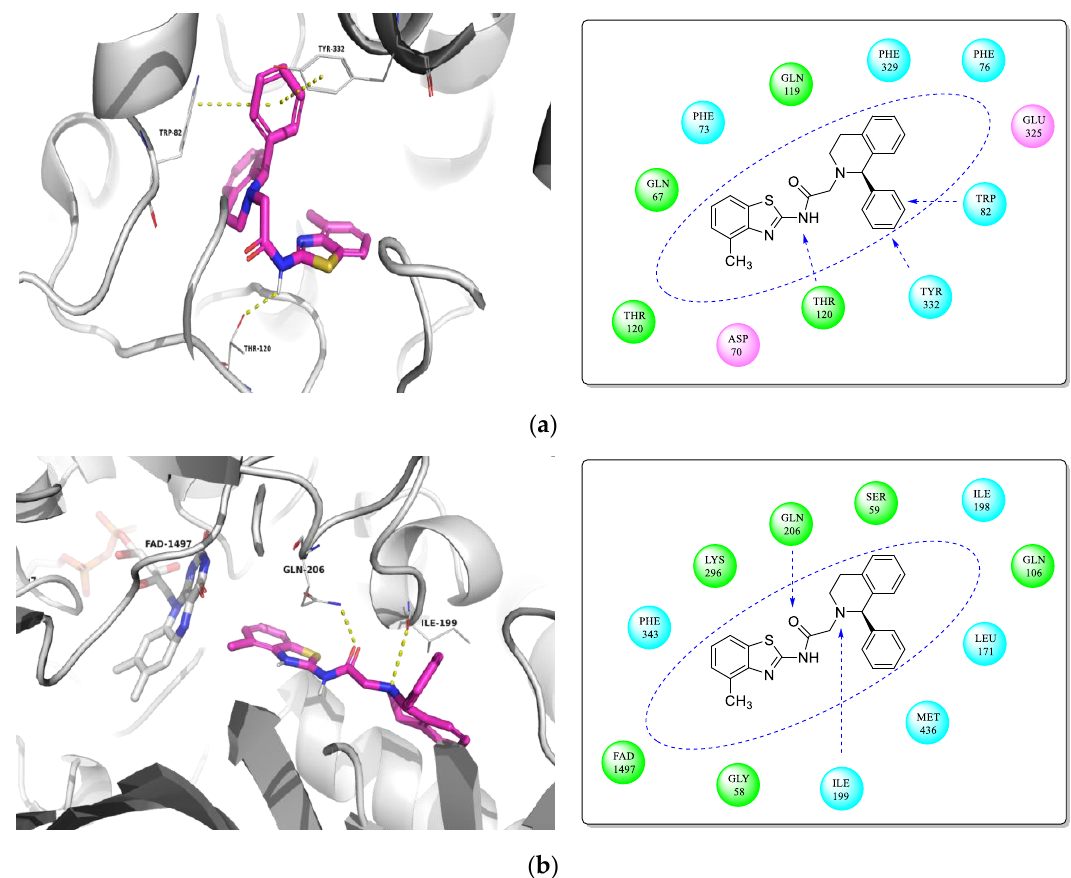
Figure 3. ( a ): Docking model of compound 4g with BuChE. Atomic colors: red carbon atoms of 4g , gray carbon atoms of BuChE residues, blue nitrogen atoms, red oxygen atoms, yellow sulfur atoms. ( b ): Docking model of compound 4g with MAO – B. Atomic colors: red carbon atoms of 4g , gray carbon atoms of MAO – B residues, blue nitrogen atoms, red oxygen atoms, yellow sulfur atoms.